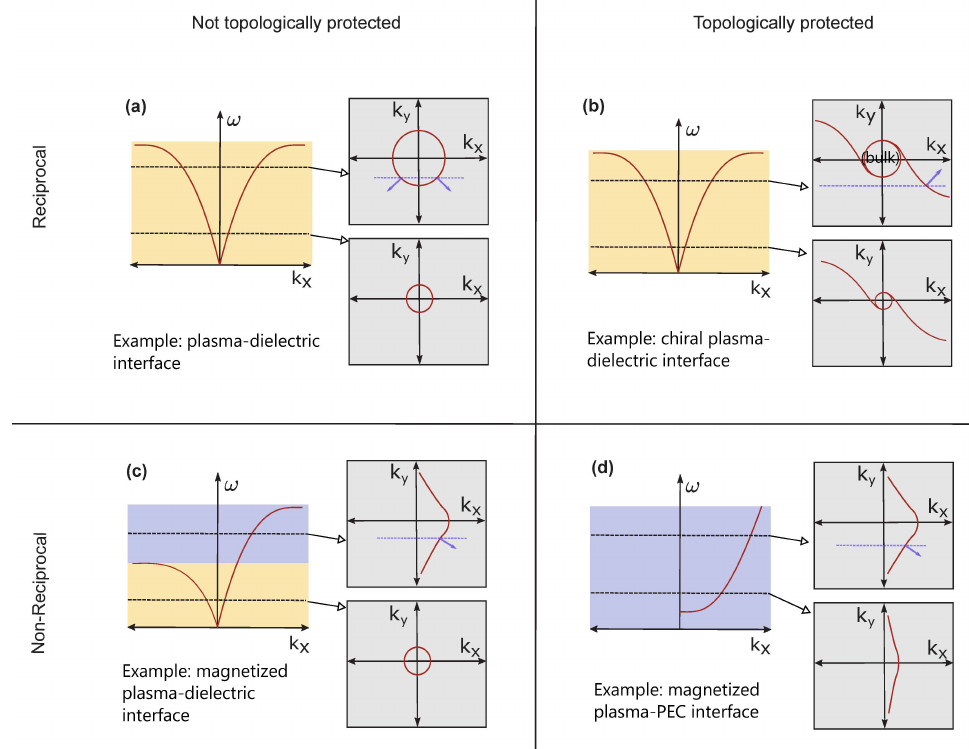
Figure 1. Reciprocal/nonreciprocal and topological/nontopological surface plasmon-polariton modes. ( a , b ) Model dispersion diagrams of reciprocal surface plasmon-polaritons that can be classified as topologically trivial and non-trivial, respectively. The equifrequency contours of the dispersion surfaces for these modes at two different frequency values are plotted on the right insets. It can be seen that the dispersion curves are symmetric in momentum space for both cases, ω ( k ) = ω ( − k ) , but contrary to ( a ), the topologically protected mode in ( b ) does not backscatter (within a certain angular range) for defects that preserve the k y component of momentum, as indicated by the dashed blue line. Blue arrows denote the group velocity vector for a certain value of momentum. ( c , d ) Examples of non-reciprocal surface plasmon-polariton modes. The equifrequency contours are strongly asymmetric in both cases, but the backward-propagating mode is completely absent (within a bulk-mode bandgap) only in the topologically protected case in ( d ).